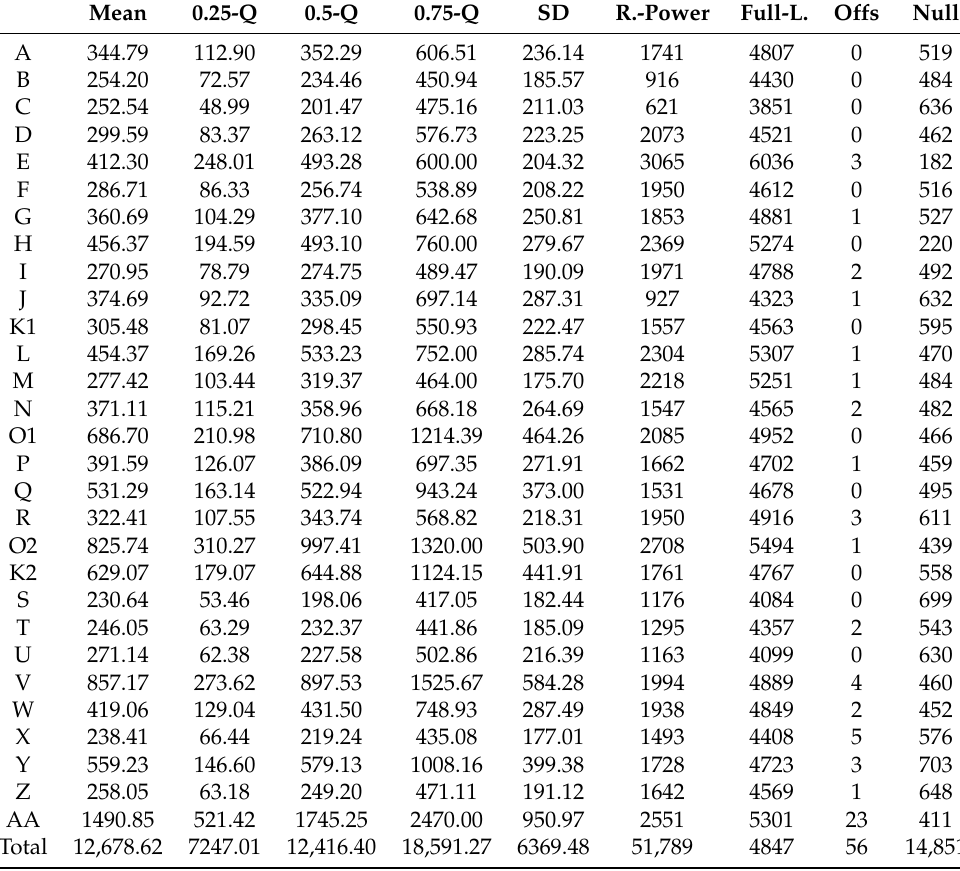
Table A3. Descriptive statistics of synthetic power production at the wind farms for the year